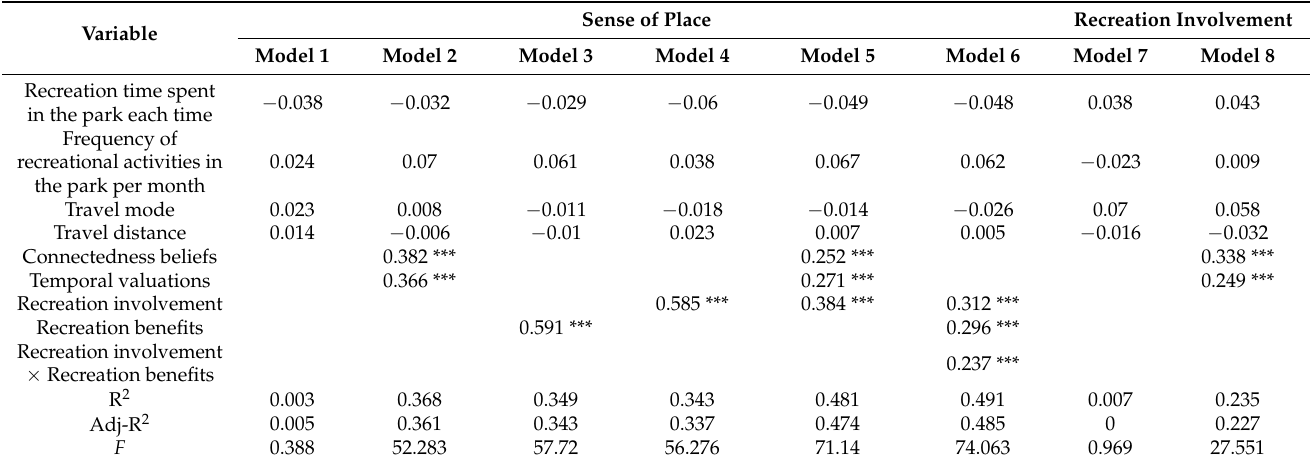
Table 5. Results of hierarchical regression.